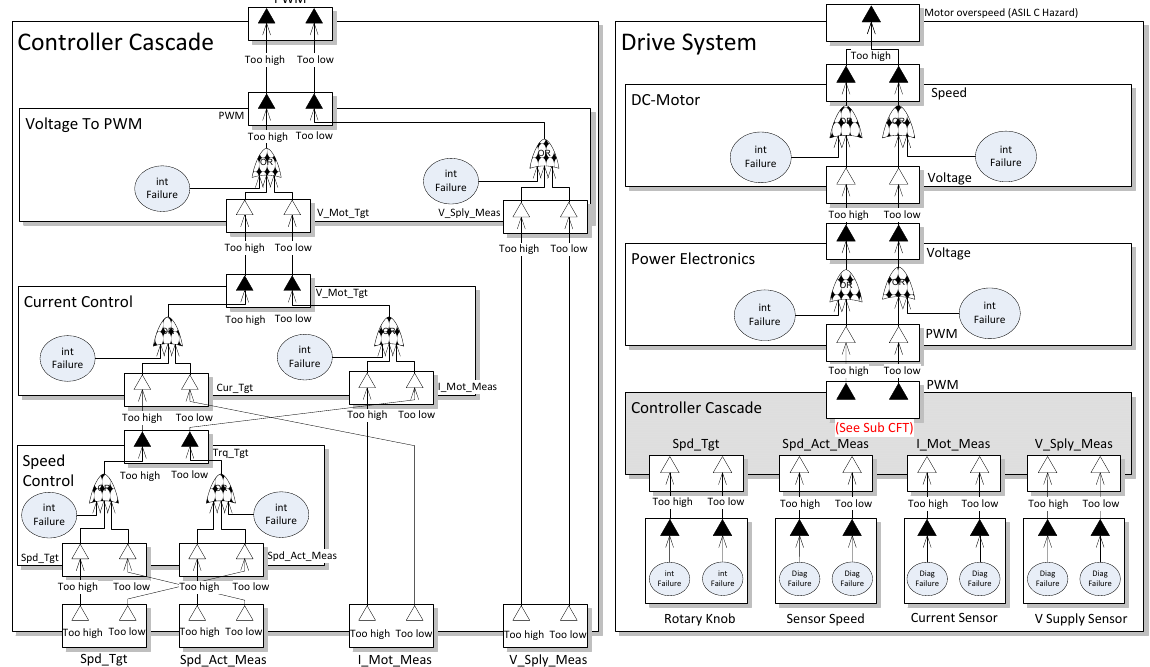
Figure 9. Component Fault Tree for DC Drive system (controller